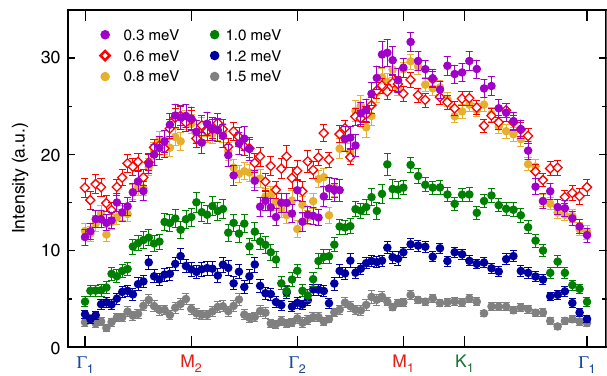
Fig. 3 Constant-energy scans at 2.5 T and 70 mK. The cuts are made along the high-symmetry directions, Γ -M- Γ -M-K- Γ , at the indicated energies. Error bars, 1 s.d.; a.u. arbitrary